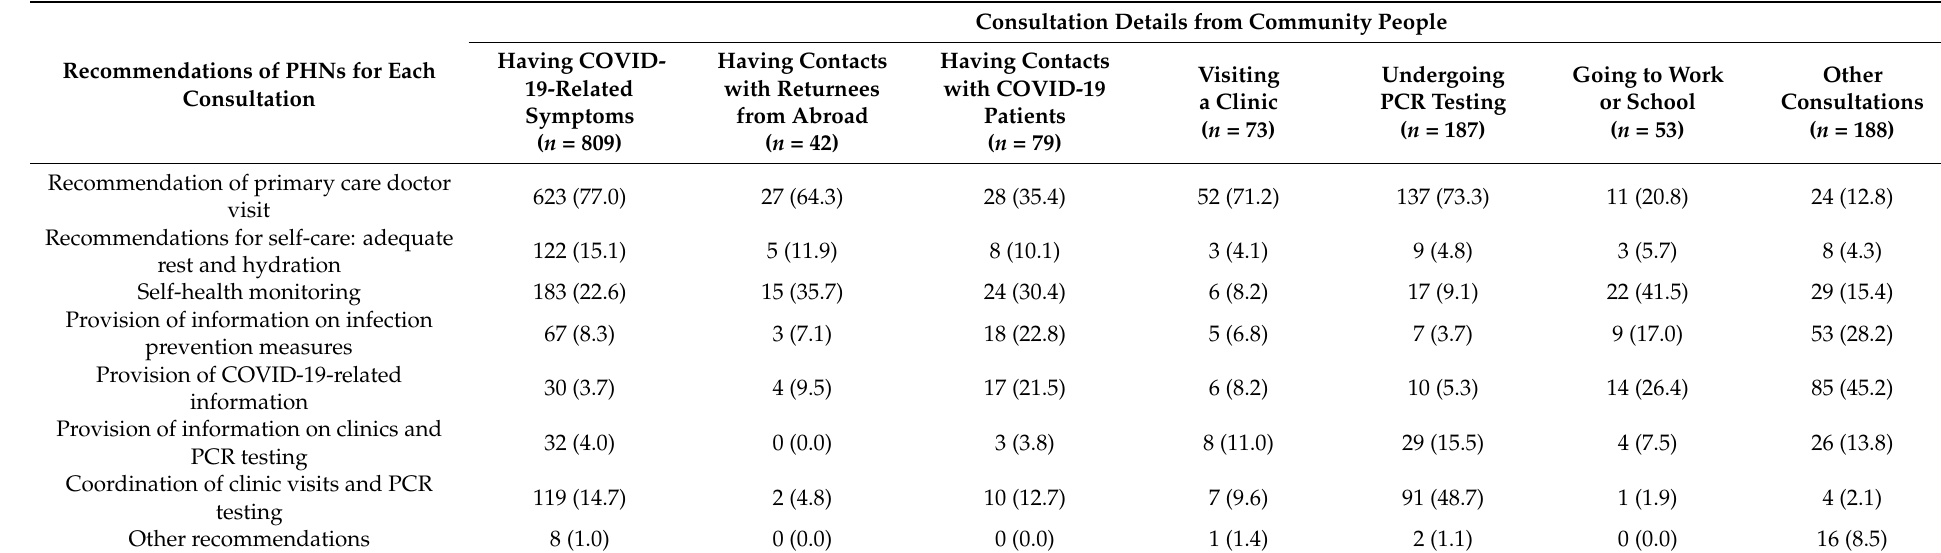
Table 3. The proportion of PHNs’ recommendations by each consultation ( N =